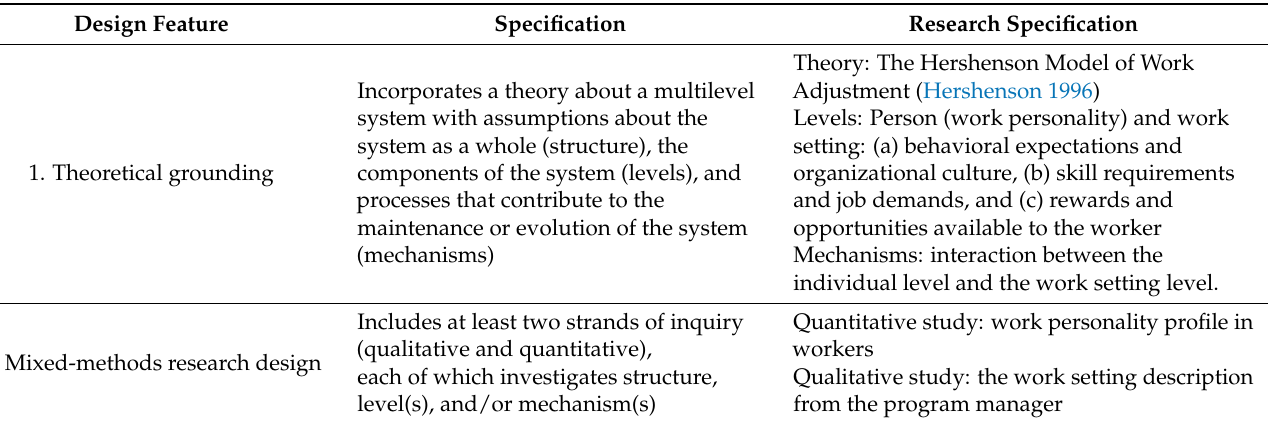
Table 1. Features of multilevel mixed-methods research designs (MMRD). Source: adapted from Headley and Plano Clark